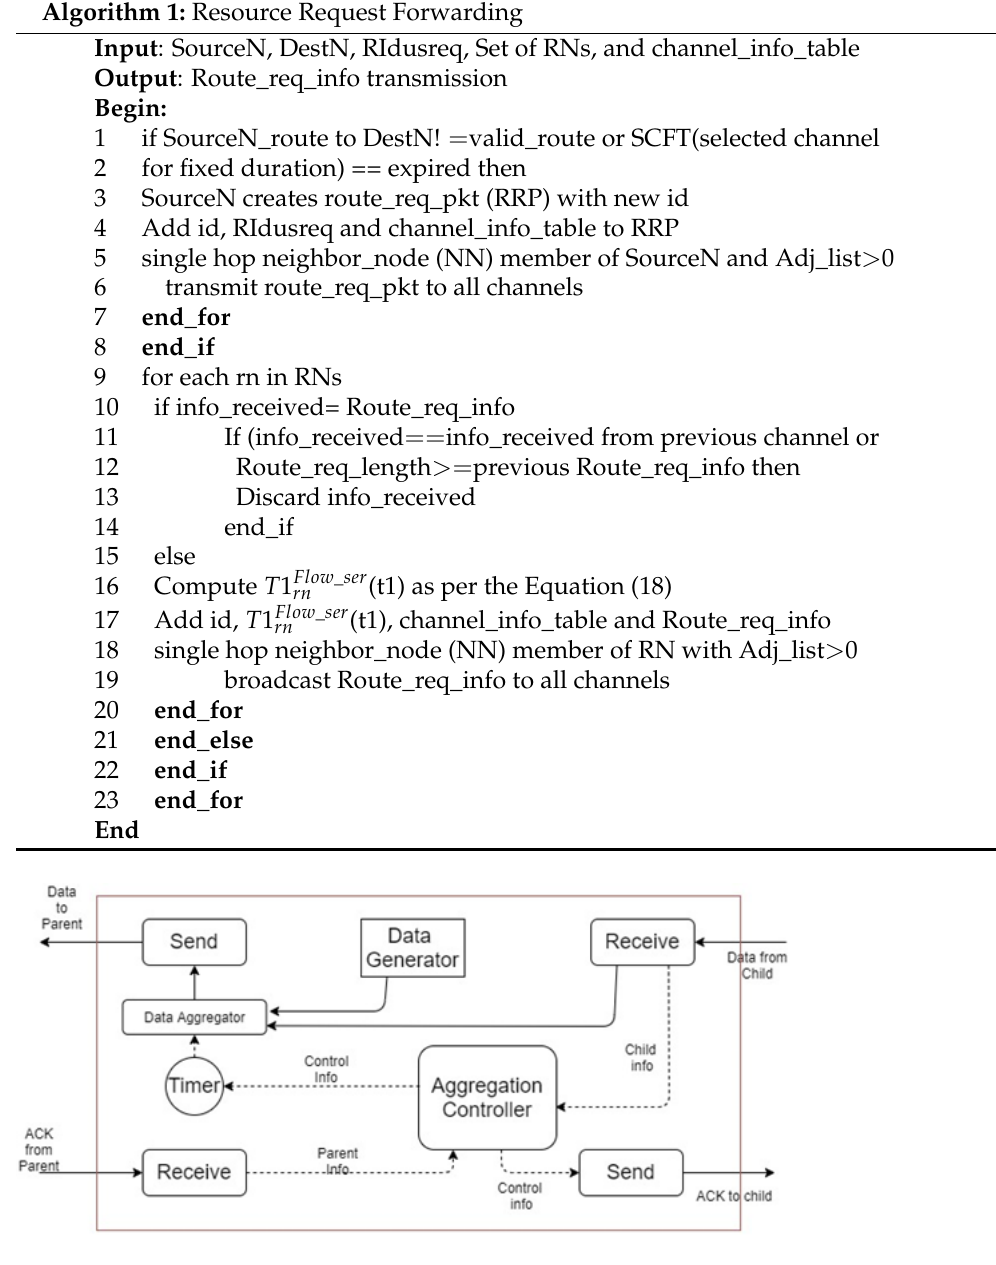
Algorithm 1: Resource Request Forwarding